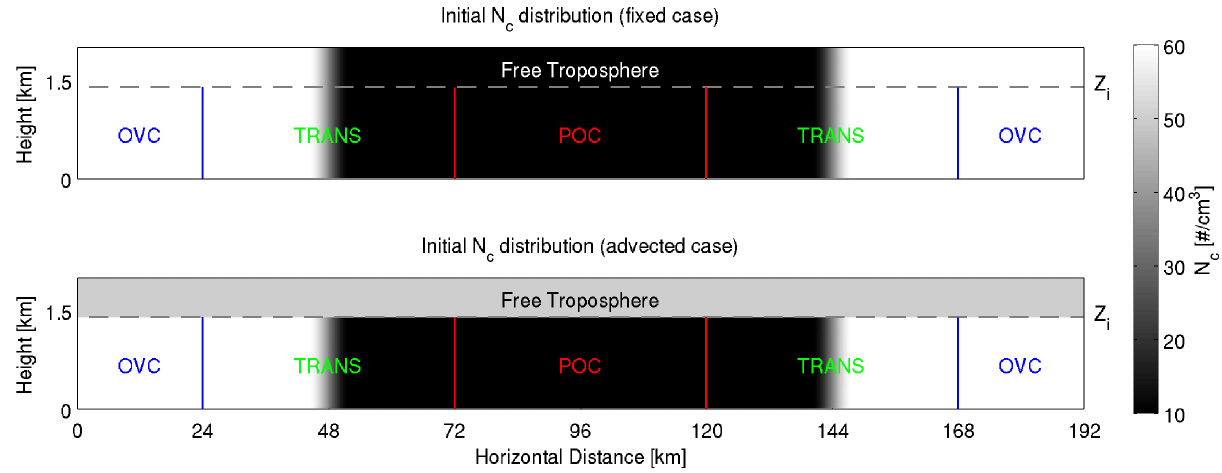
Fig. 3. x - z cross-section of N c initialization for the NCFIXED and NCADVECT simulations. Sampling regions for profiles, time-series, and other statistics are also depicted. Initialization is homogeneous in y . Red lines enclose the POC sampling region, the blue lines to domain edge enclose the OVC sampling region, and all remaining area is considered transitional (TRANS).